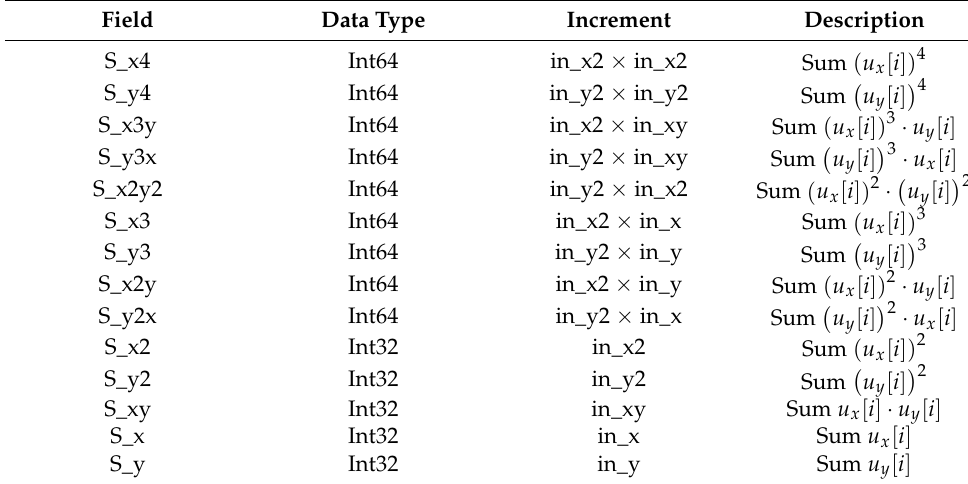
Table 2. Calculations of the covariance matrix.